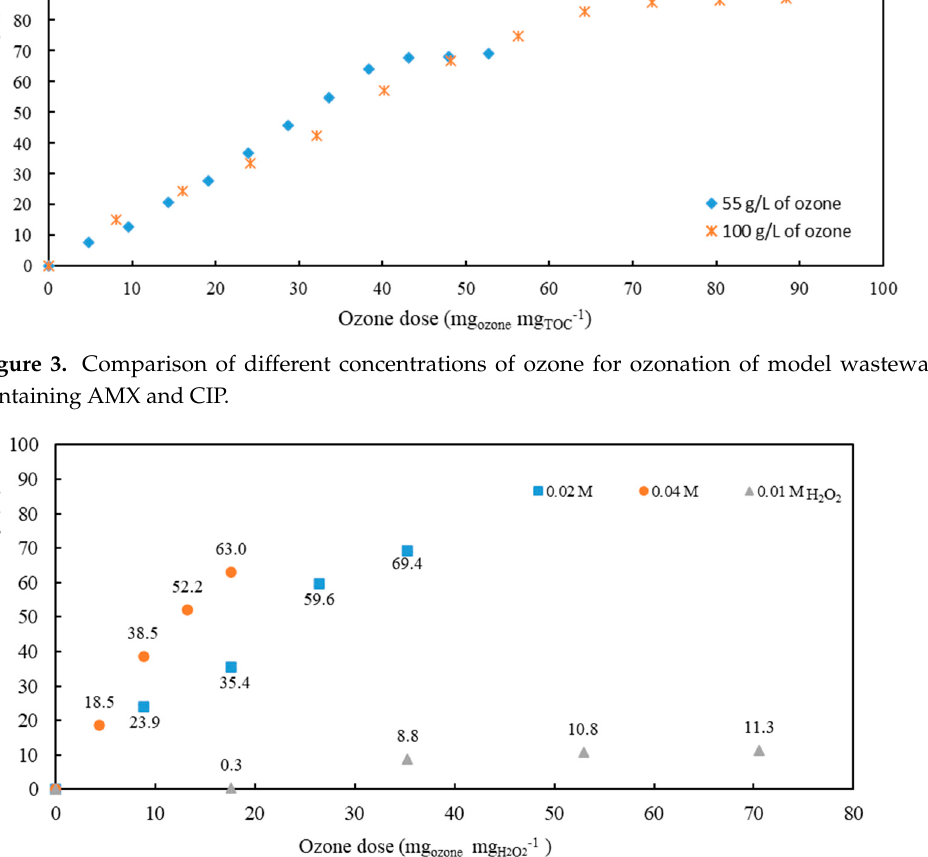
Figure 4. TOC removal efficiency at pH = 10.85 and different dosages of H 2 O 2 in model wastewater containing AMX and CIP.